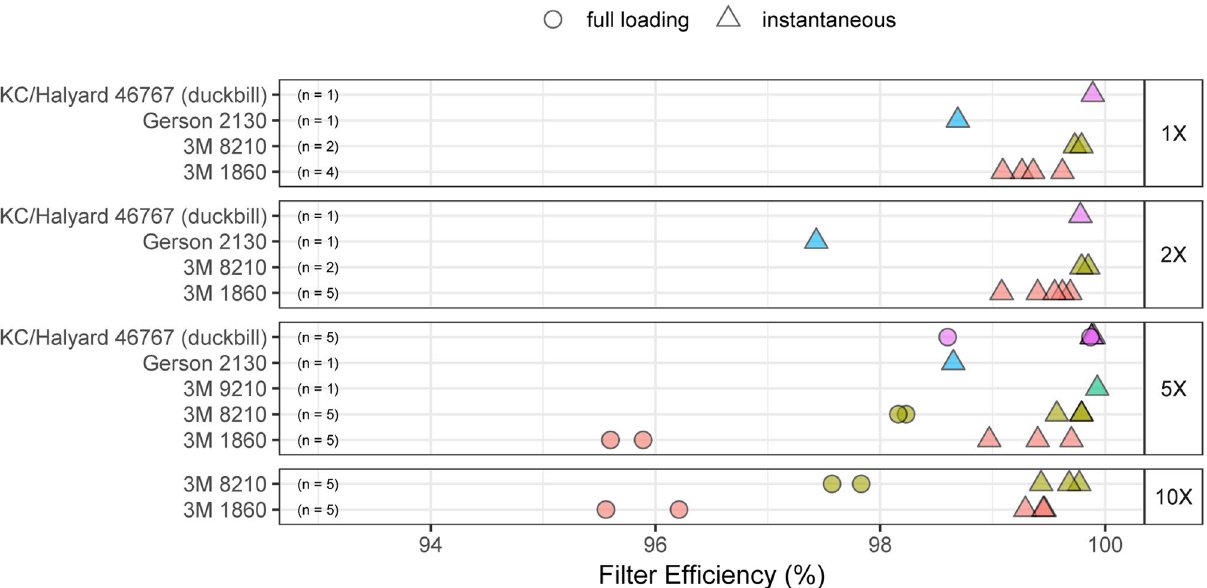
Figure 1. Instantaneous and fully-loaded ambient particulate matter filtration data for N95 masks over one, two, five, and 10 SteraMist sterilization cycles (1 ×, 2 ×, 5 ×, and 10 × respectively). “KC” corresponds to Kimberly-Clark. Figure marker color corresponds to mask model type (listed on y-axis). Results were obtained from ICS Laboratories according to NIOSH standard Procedure No. TEB-APR-STP-0059. All masks passed ICS standards, including filtration efficiency of ≥ 95%.